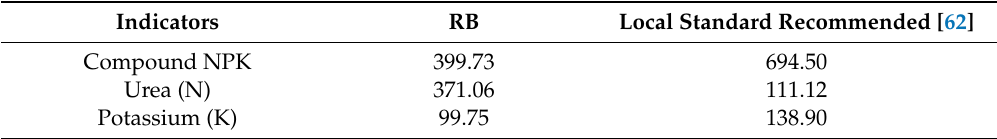
Table 4. Utilization of synthetic fertilizers in rice production. Unit: Kg / ha /